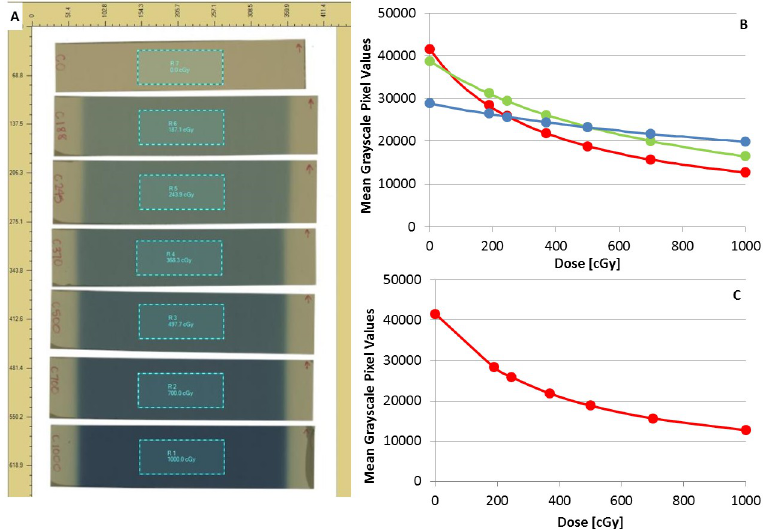
Fig 3. Radiochromic film processing and calibration procedure. A) ROI placement on film; B) Calibration curve made with FilmQA Pro; C) calibration curve made with ImageJ.